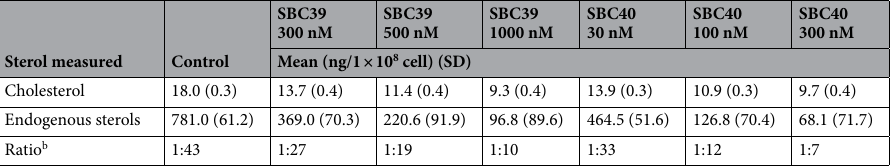
Table 2. Cholesterol and endogenous sterols a contents in control and SBC-treated L. amazonensis promastigotes. Mean and standard deviations (SD) were calculated from three parallel measurements ( n = 3). a Endogenous sterols = Ergosta-8,24(24 ′ )-trien-3β-ol, 5-dehydroepisterol and episterol. b The cholesterol:endogenous sterols